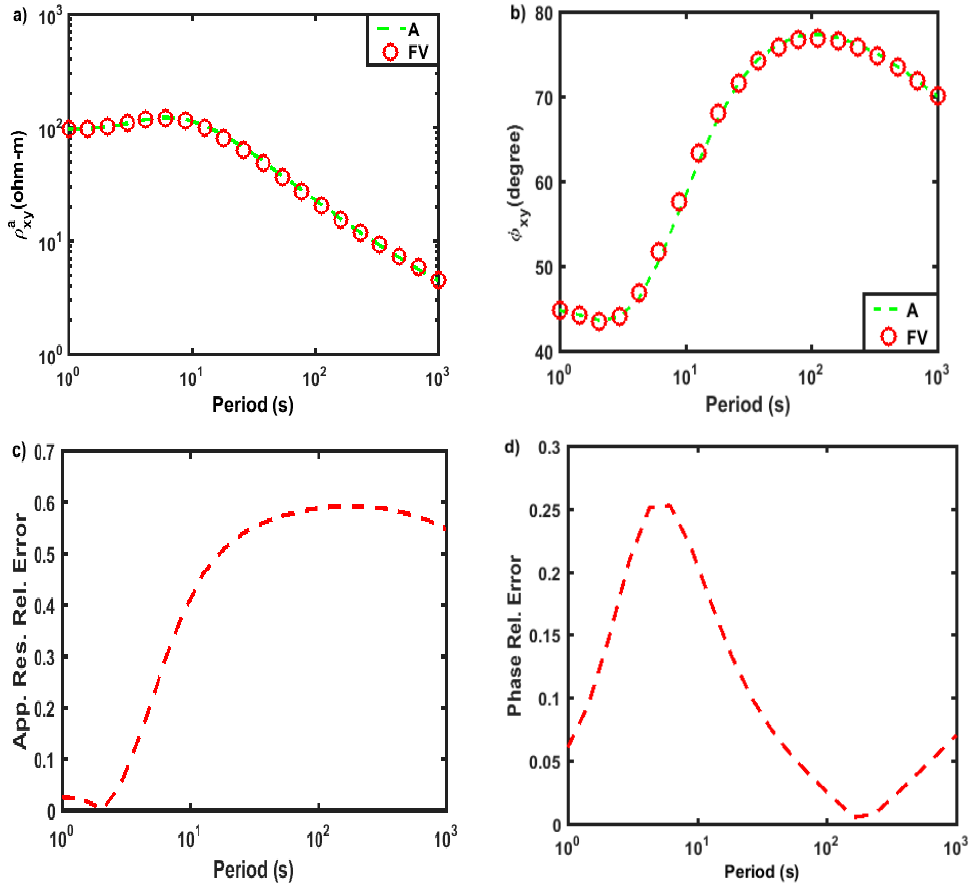
Figure 3. The plot of the ( a ) apparent resistivity ( b ) phase for the E x polarization using the finite volume (FV) approach and the analytical (A) method. And the ( c ) apparent resistivity relative error ( d ) phase relative error of the finite volume method. The solid dash green lines indicate the analytical (A) solution while the red circle denotes the finite volume (FV) approach. And the solid dash red lines indicate the relative error for the FV method.